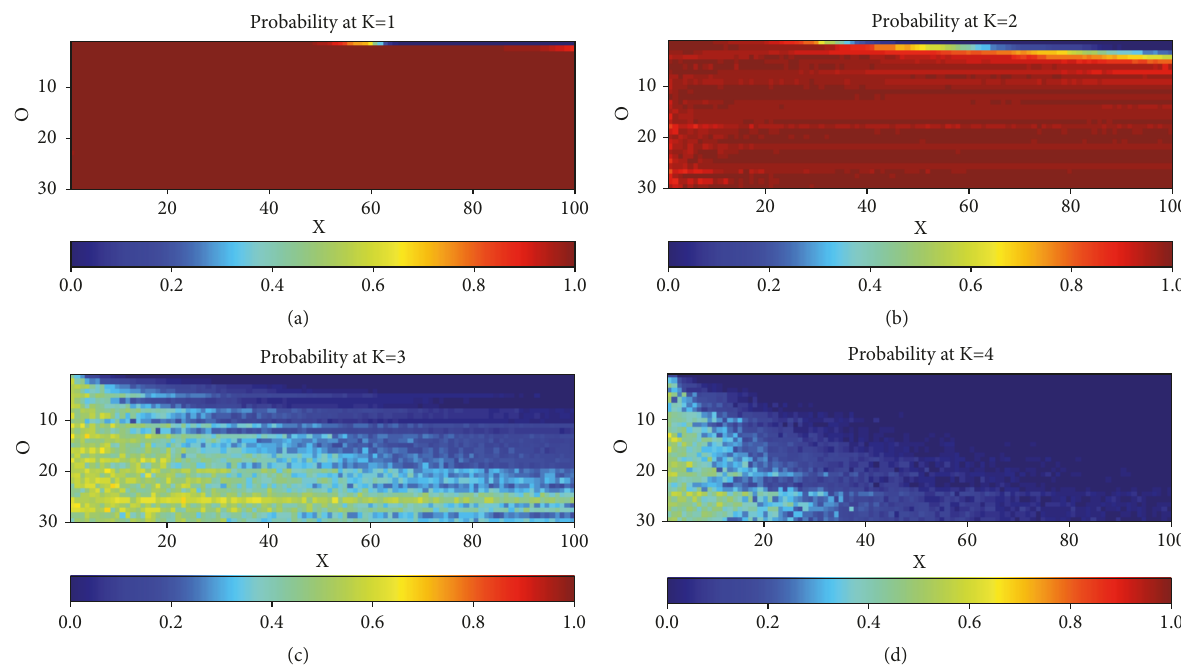
Figure 6: Probability of generating antifragile networks depending on 𝑋 and 𝑂 for ordered, critical, and chaotic RBNs with 𝑁 = 100, 𝑇 = 200, 𝑝 = 0.5. 50 different networks were used. 10 different initial states were randomly chosen for each network. (a) 𝐾 = 1. (b) 𝐾 = 2. (c) 𝐾 = 3. (d) 𝐾 =